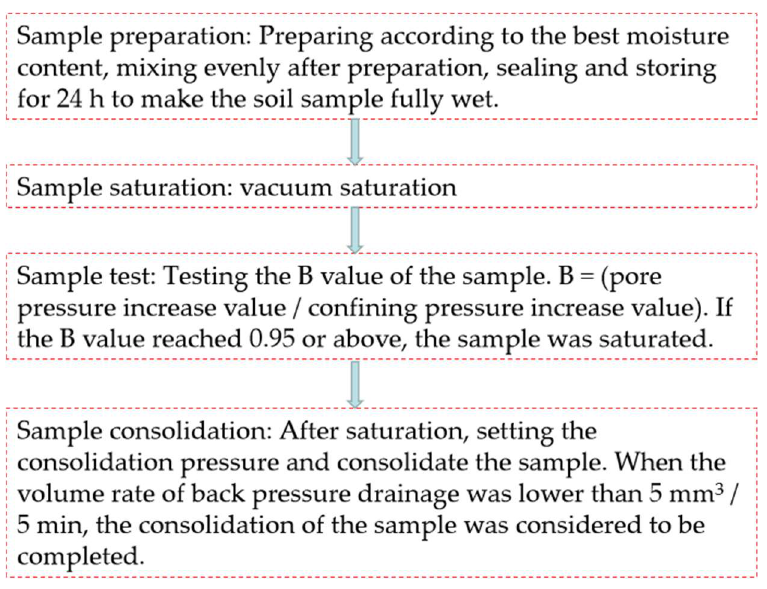
Figure 3. The entire research process.